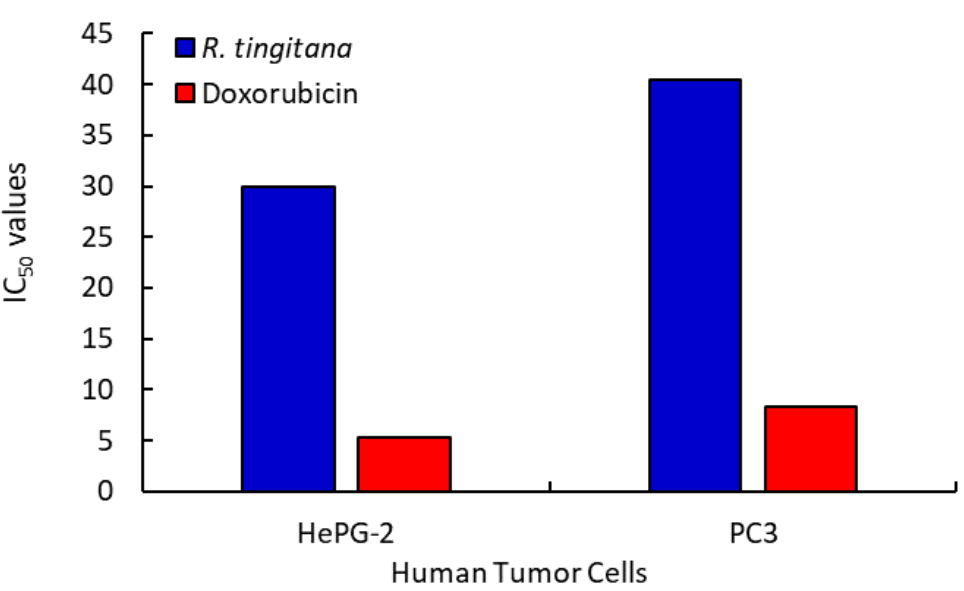
Figure 4. IC 50 values of the tested plant sample and doxorubicin as standard against human cancer cells.